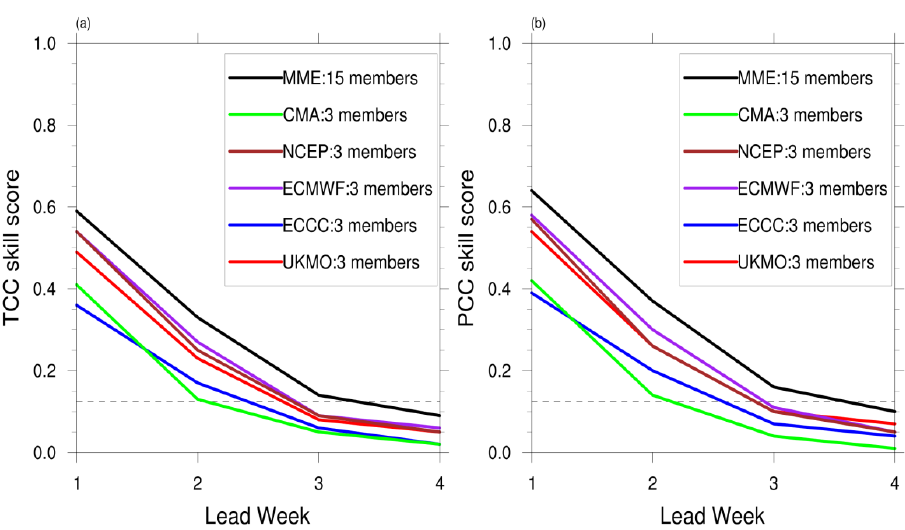
Figure 4. Spatial average of the TCC ( a ) and time average of the PCC ( b ) over the MC. CMA, NCEP, ECMWF, ECCC, UKMO, and the 15-member MME are, respectively, plotted in green, brown, purple, blue and red. The dashed black line represents the 95% significance threshold.